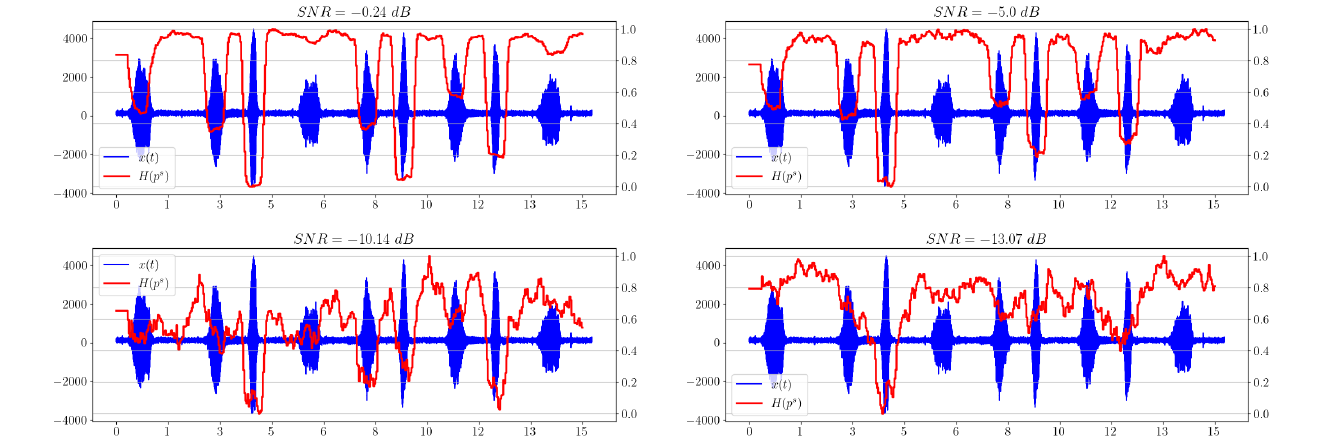
Figure 5. Spectral entropy plots for different